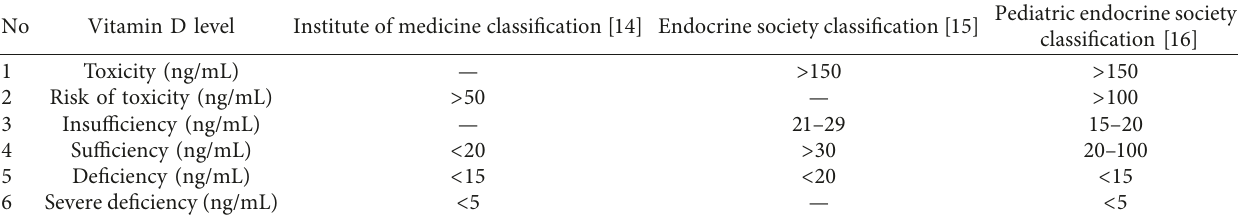
Table 1: Recommendations for vitamin D level in human.